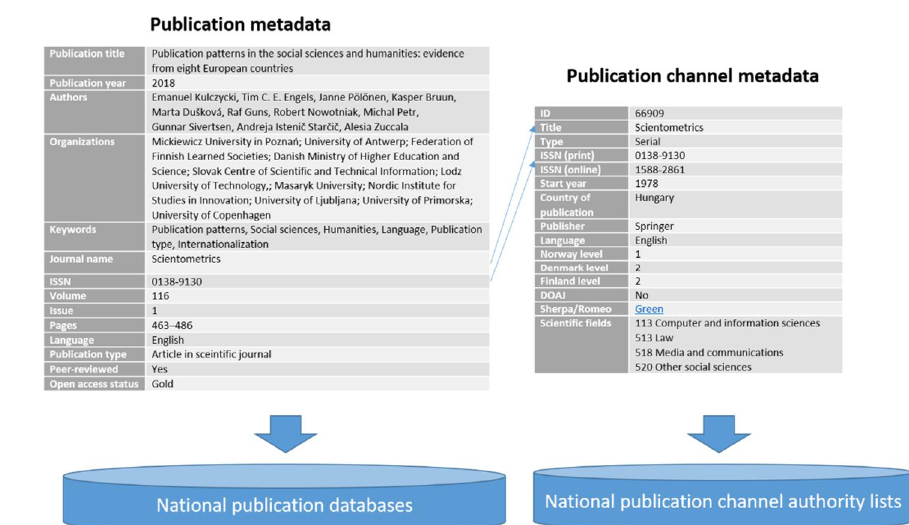
Fig. 3 . Example of a publication’s metadata, and a publication channel’s metadata currently included in the national